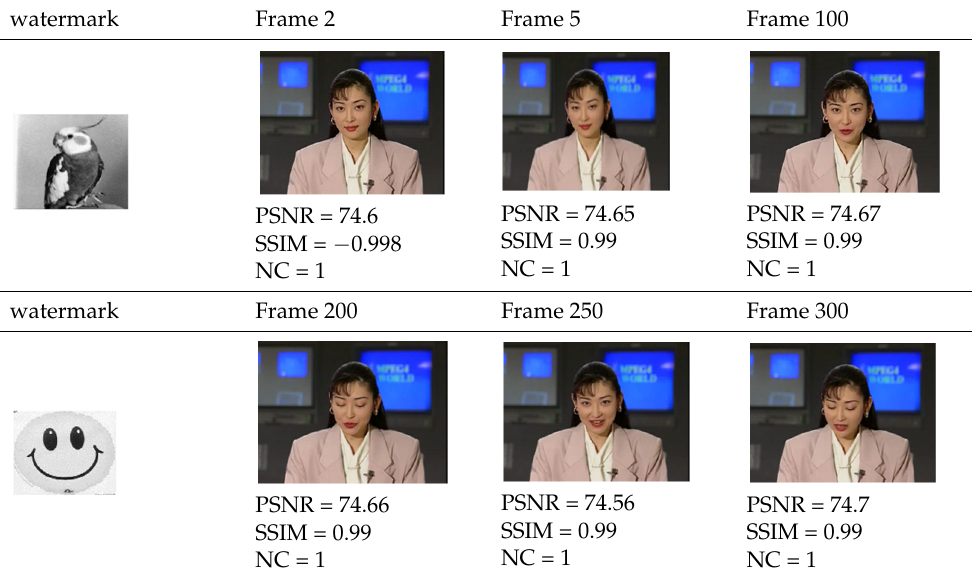
Table 2. PSNR, SSIM, and NC of watermarked Akiyo.mp4.